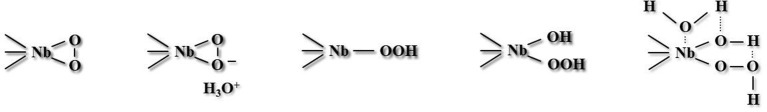
Possible arrangements of peroxo and hydroperoxo Nb species discussed in literature (adopted from Ivanchikova et al., 2017).